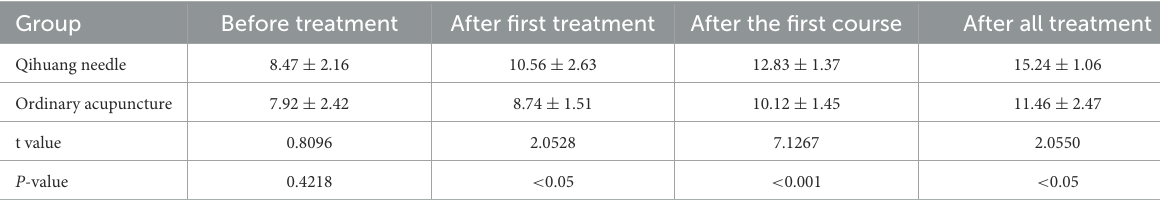
TABLE 4 Treatment courses between the two groups. Group Effective rate after 1st Effective rate after 2nd course (cases) course (cases)